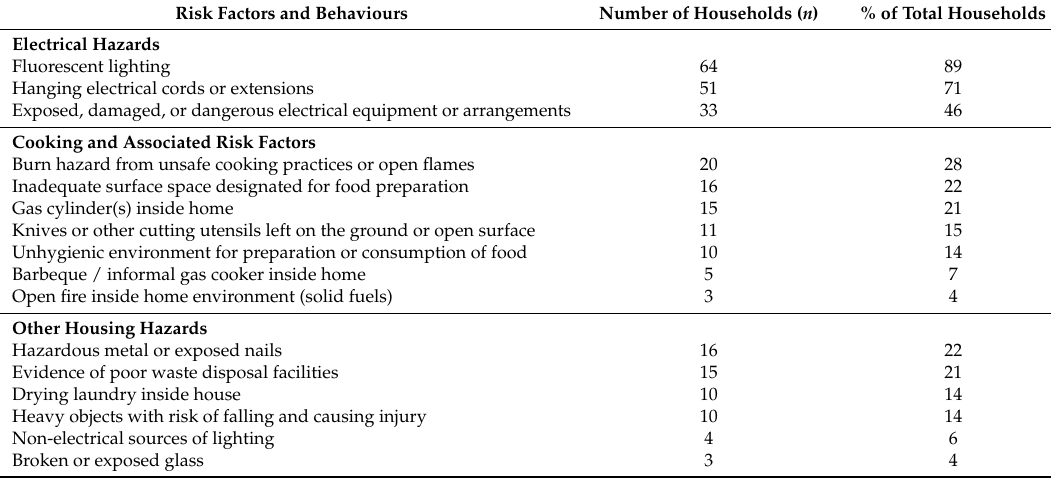
Table 2. Risk factors and behaviours associated with negative health outcomes to which the children were